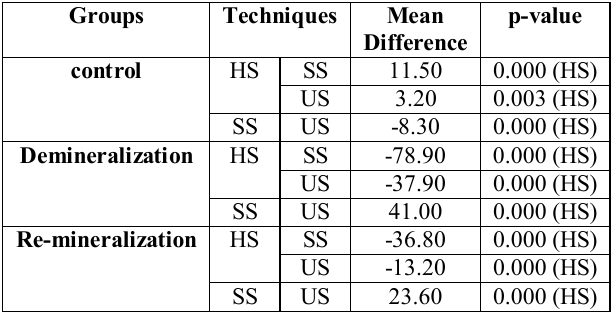
Table 5: LSD test for the total sample